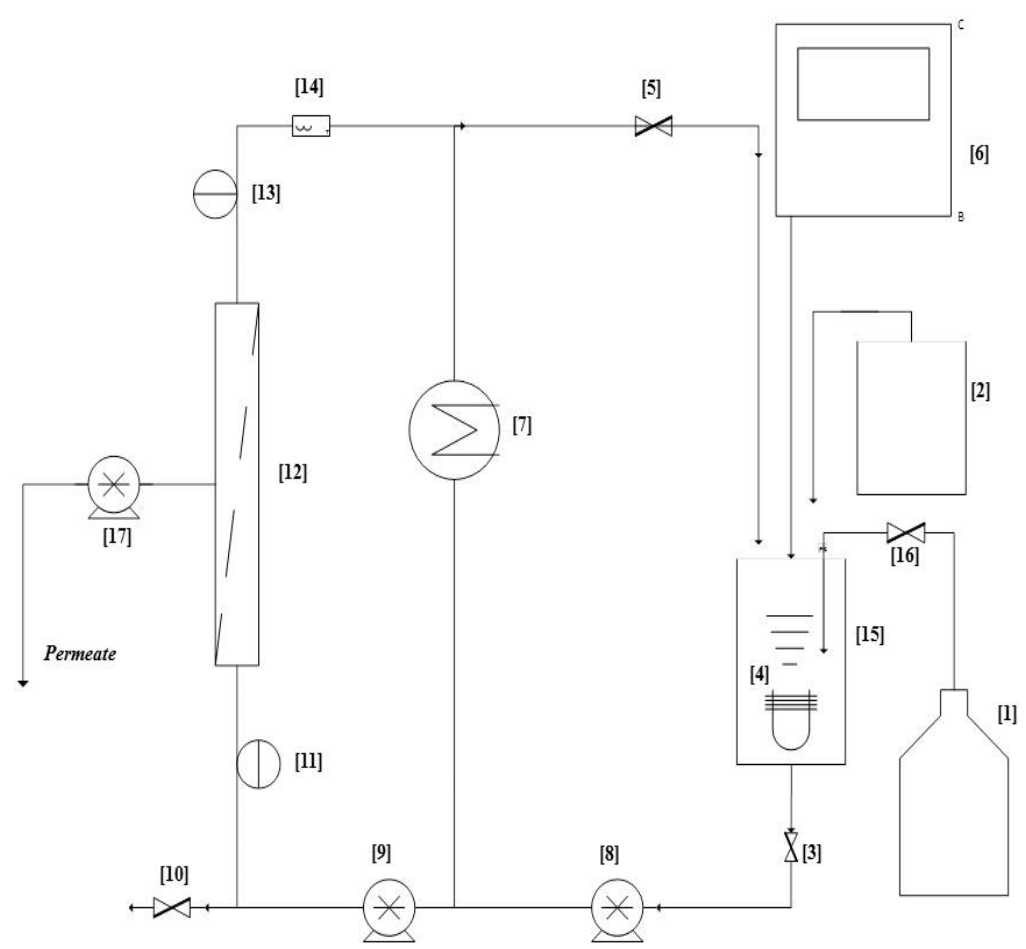
Figure 2. Schematic diagram of the membrane bioreactor (MBR) (1) Nitrogen gas supply (2) Feed